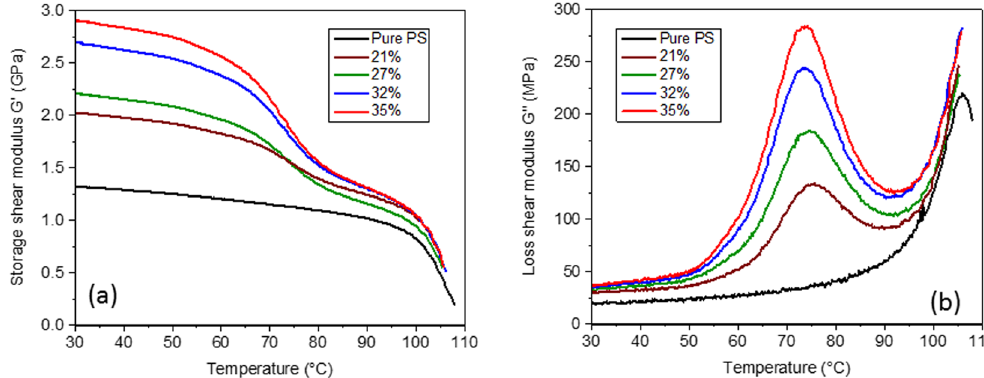
Figure 3. Experimentally measured dynamic temperature scans. ( a ) Storage shear modulus for coated particle filled samples at particle volume fractions from 21% to 35%. ( b ) Loss shear modulus for coated particle filled samples at particle volume fractions from 21% to 35%.